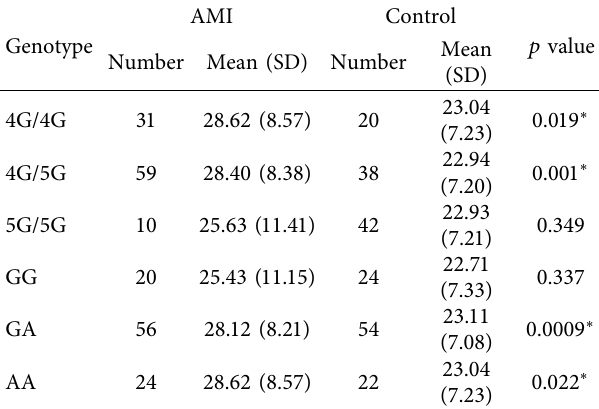
Table 9: Comparison of PAI level (ng/ml) according to 4G/5G and -844G/A polymorphism in the AMI cases and control groups.